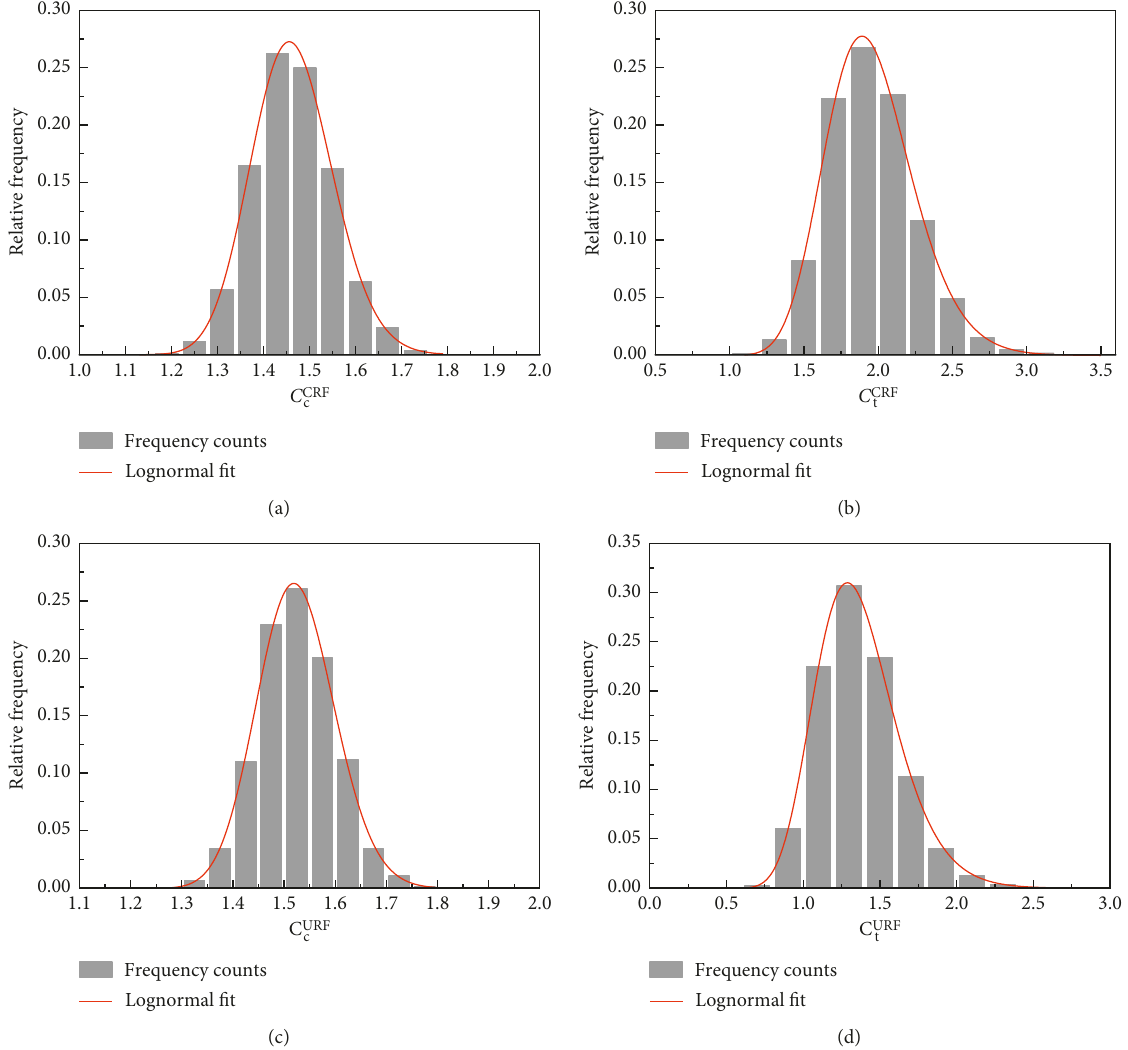
Figure 5: Typical histograms and lognormal fits of strength factors: (a) C CRF